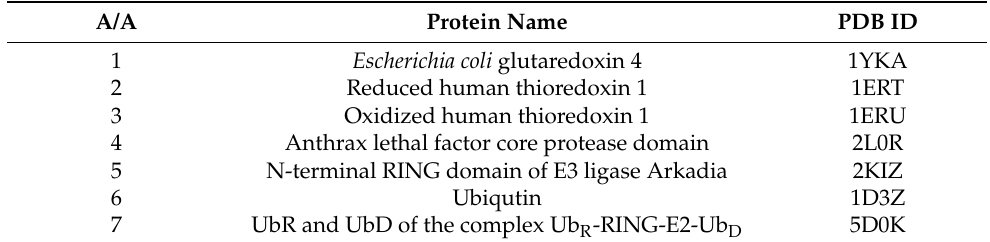
Table 1. Names of proteins and PDB codes that were used for the constructions of protein struc- ture